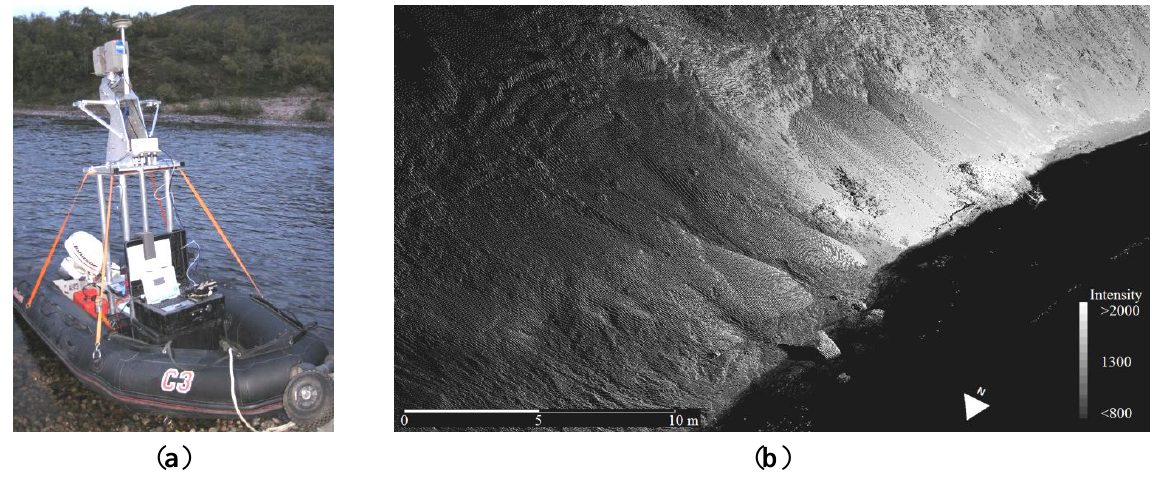
Figure 6. ( a ) A boat-mounted MLS for mapping of fluvial processes; ( b ) 20 m high river bank subject to flood erosion mapped using a boat-mounted MLS. Geomorphological features are easily detected due to the dense point